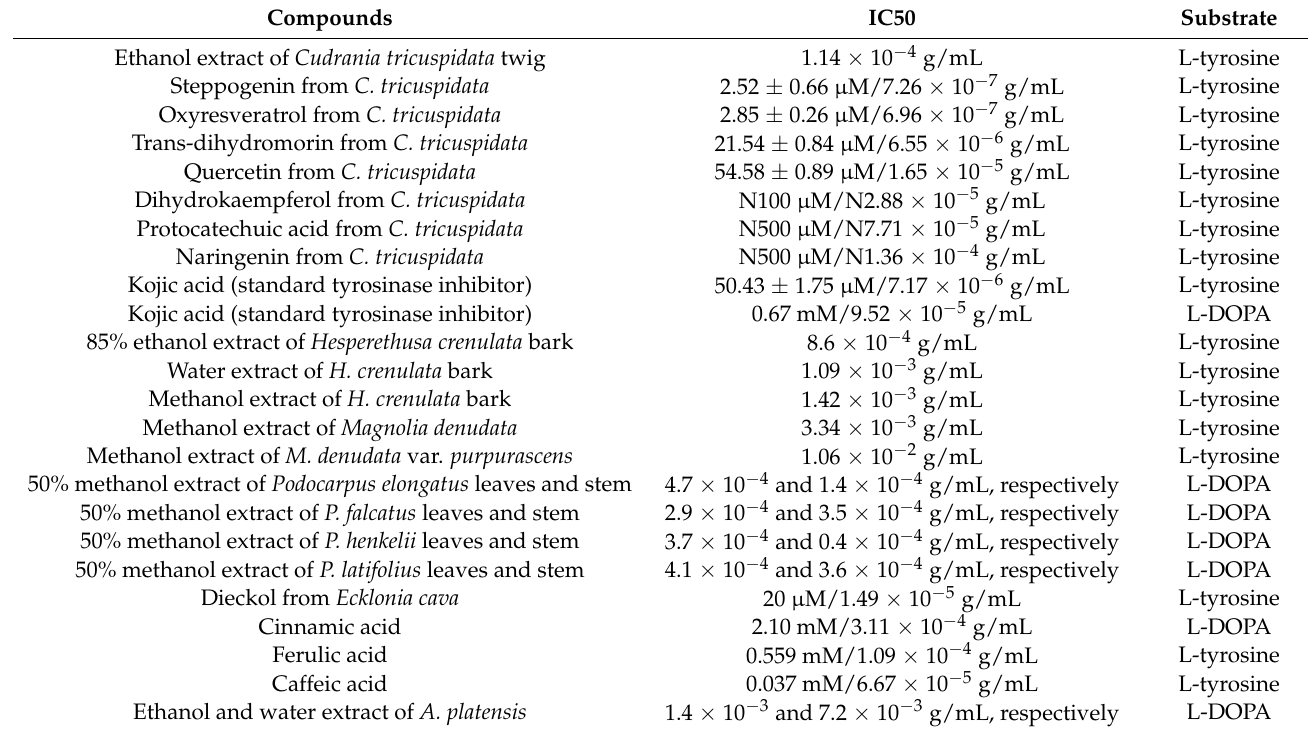
Table 4. Natural blends with inhibitory activity of tyrosinase. Published by Ref. [36] and references therein.